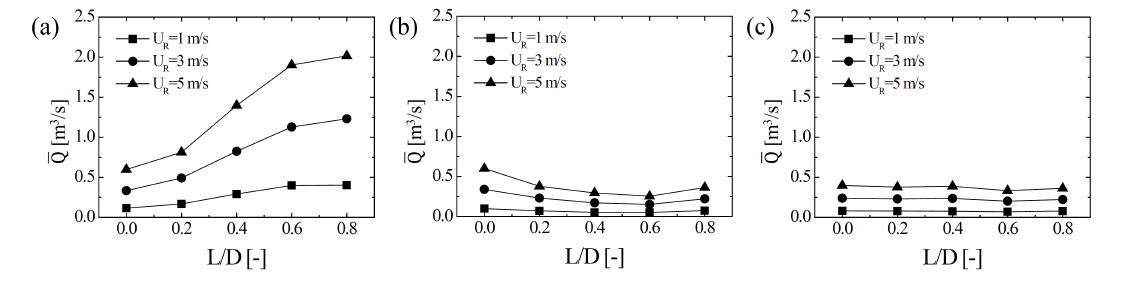
Figure 5. Effect of the overhang length ( L / D ) on the ventilation rate: ( a ) windward direction; ( b ) leeward direction; and ( c ) side direction.